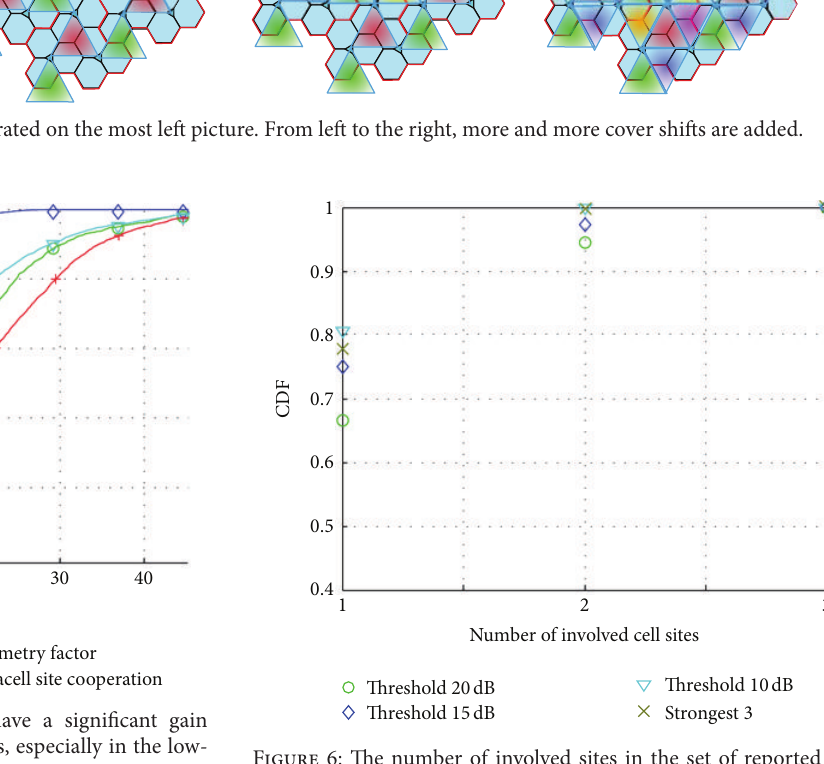
Figure 6: The number of involved sites in the set of reported BS depends on the number of reported BSs and thus on the threshold if that selection approach is chosen.